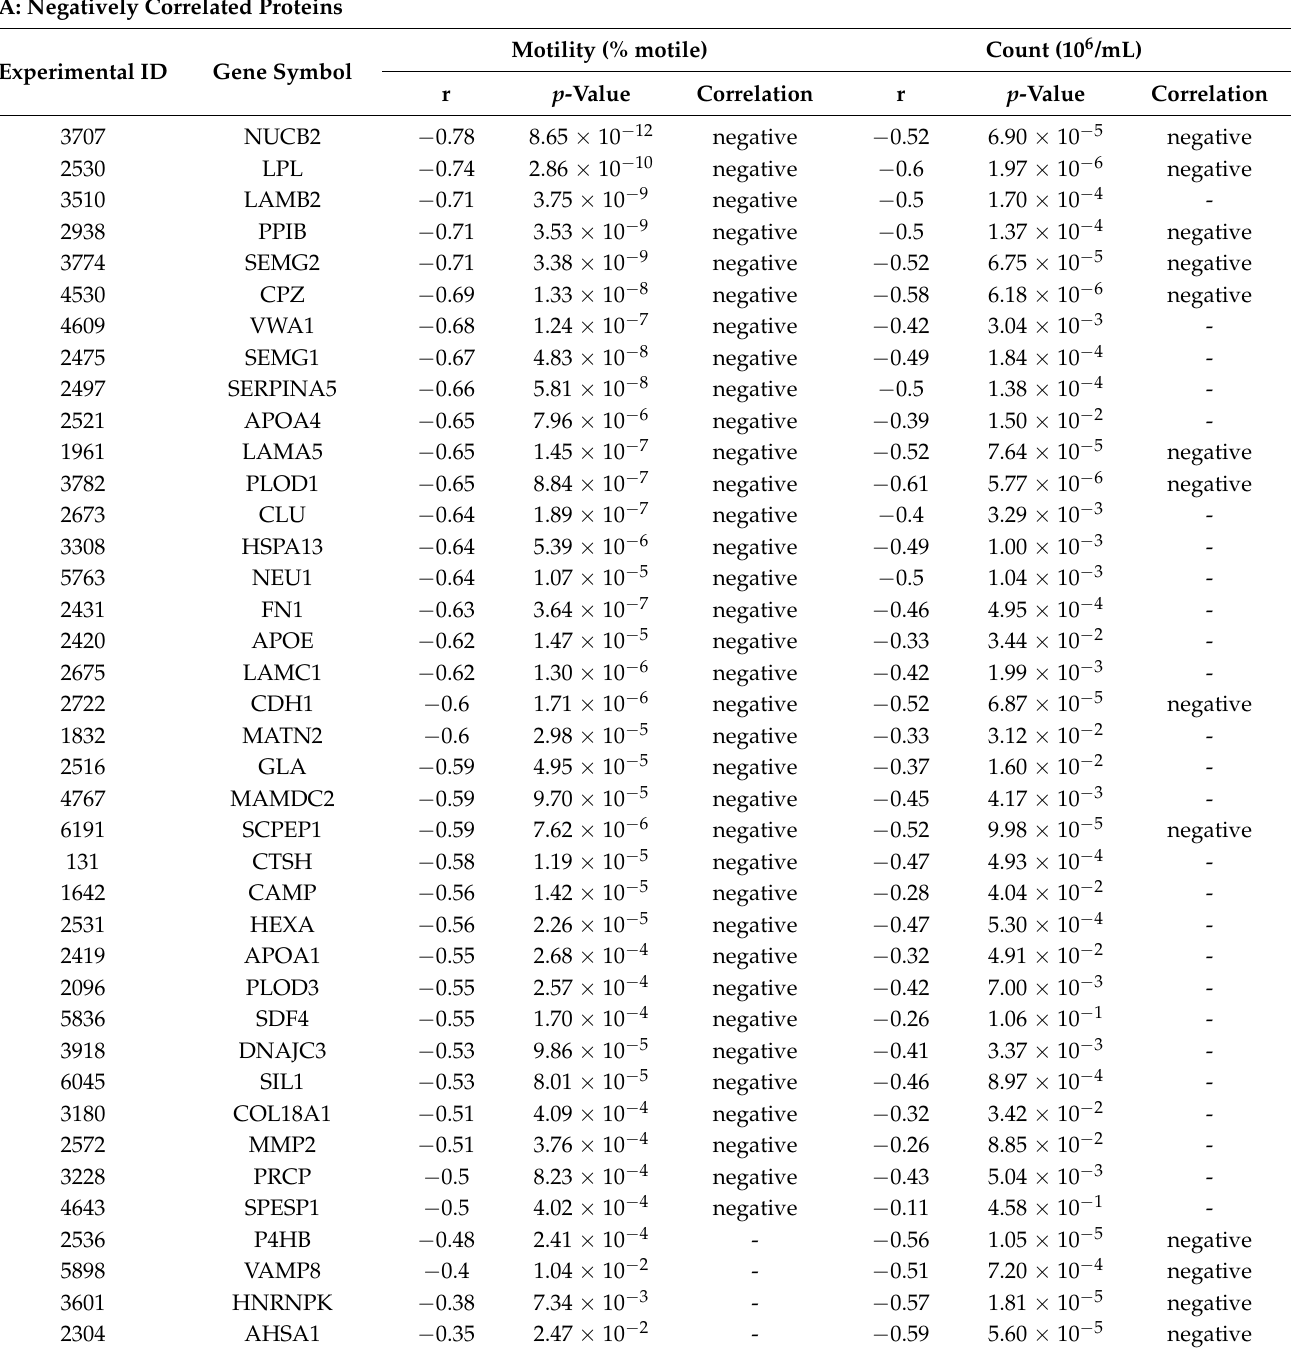
Table 2. Correlation of protein abundance level as determined by LC-MS/MS with the basic semen parameters sperm motility and sperm